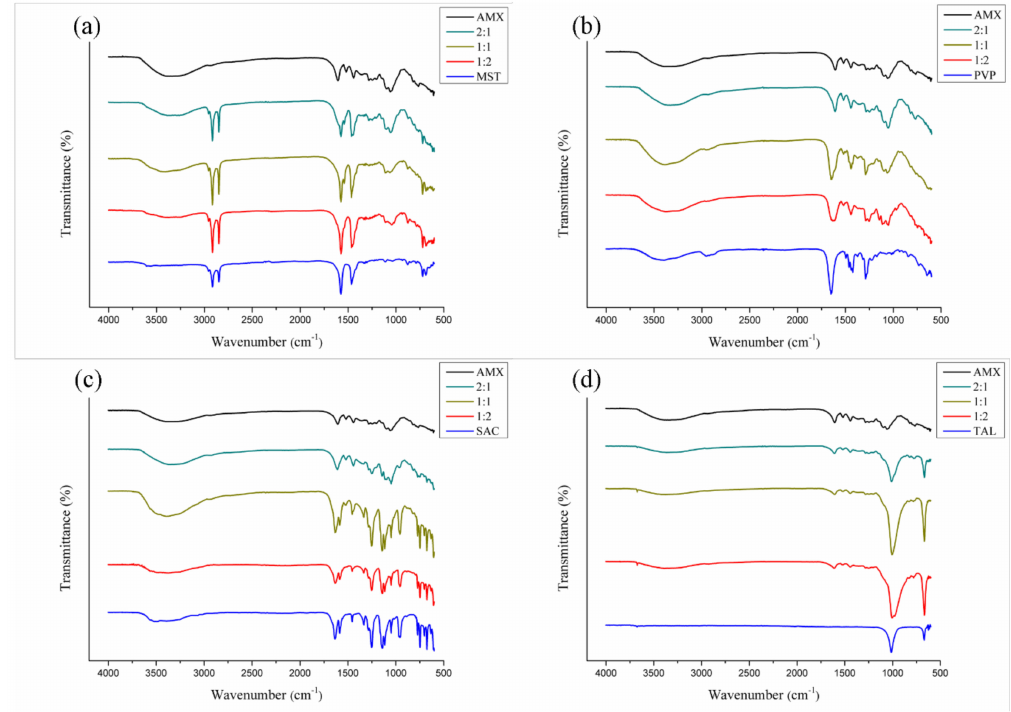
Figure 7. FTIR spectra for binary mixtures of AMX and pharmaceutical excipients: magnesium stearate ( a ), polyvinylpyrrolidone k-30 ( b ), sodium saccharin ( c ), and talc ( d ).